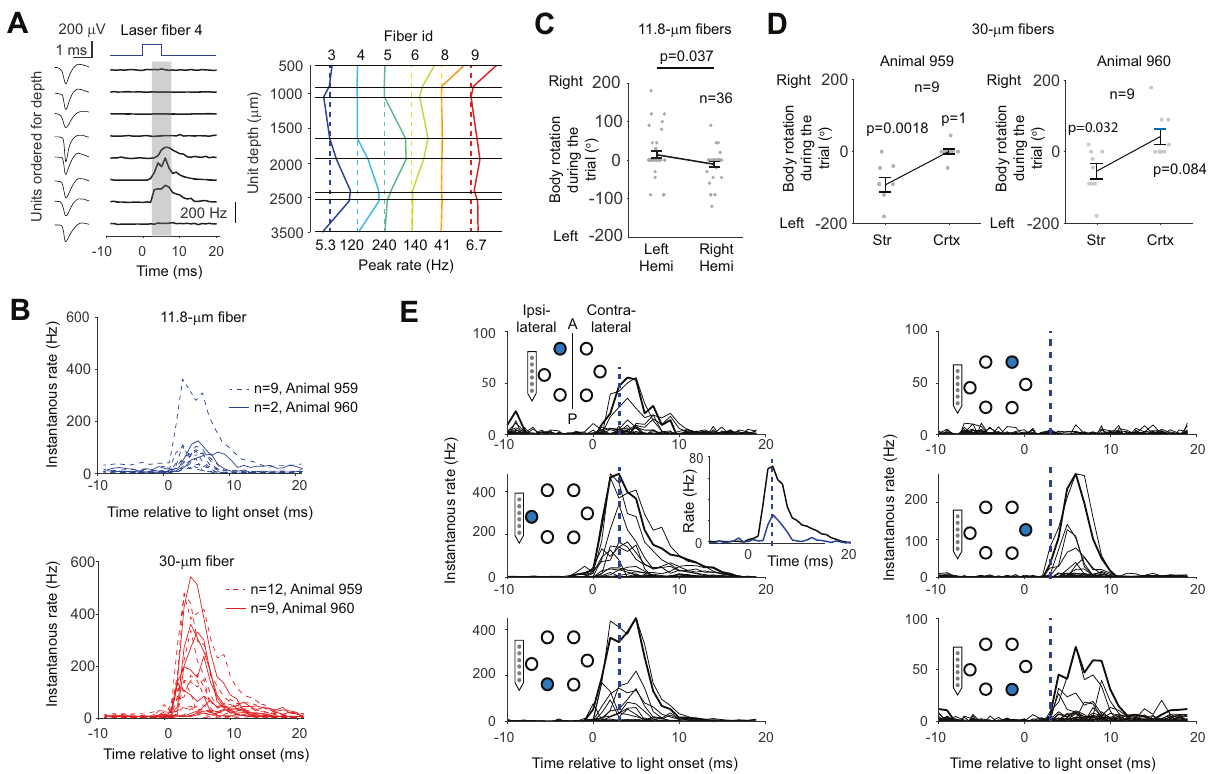
Fig. 4 Three-dimensional optogenetic stimulation and laminar recordings in freely moving mice. A Depth-resolved activation of sorted units (spike shapes: left column). For each unit, the fi ring rate was calculated 3 – 8 ms after light onset (the gray shaded area in the middle column), and the background fi ring rate preceding light onset was subtracted to quantify the light-evoked rate modulation for different units, depths, and fi bers (right column, responses for a certain fi ber is coded with a pseudocolor). Fiber 7 was nonfunctional and was removed for clarity. The emitted intensities from the 11.8 and 30 μ m fi bers were estimated before implantation to be in the ranges of 0.5 – 1 and 1.5 – 3 mW, respectively. B Units with signi fi cant activations for 11.8 (upper, blue lines) and 30 μ m (bottom, red lines) fi bers from two animals. The number of units that responded to the light is denoted by n . The total numbers of units were 12 for animal 960 and 25 for animal 959. C Optogenetic effect for left and right optical fi ber on behavior measured in body rotations. In both hemispheres, all two, three, four, and fi ve fi bers were stimulated in nine trials each, resulting in 36 trials in total for each hemisphere. The amount of body turning was estimated through visual inspection across four cameras. Error bars denote the standard deviation of the mean. Two-sided t -test, not corrected for multiple comparisons. D Behavioral effect for depth-resolved stimulation in cortex (Crtx) versus striatum (Str) for the 30 μ m fi bers in the right hemisphere. The behavior was estimated according to panel C . The number of trials is denoted by n . Error bars denote the standard deviation of the mean. Two-sided t -test, not corrected for multiple comparisons. E Cortical recordings during the stimulation of six different super fi cial 30 µ m fi bers (stimulated fi bers are indicated by a blue circle) organized bilaterally at three different positions along the anterior (A) – posterior axis (P). To rule out that longer latencies for the stimulation on the contralateral hemisphere (right column) were due to light leakage to the recorded hemisphere, we calculated the peak latency (vertical dashed blue line) for the minimum light intensity in the recorded hemisphere that generated a response (blue response curve in the middle inset). Source data are provided as a Source Data